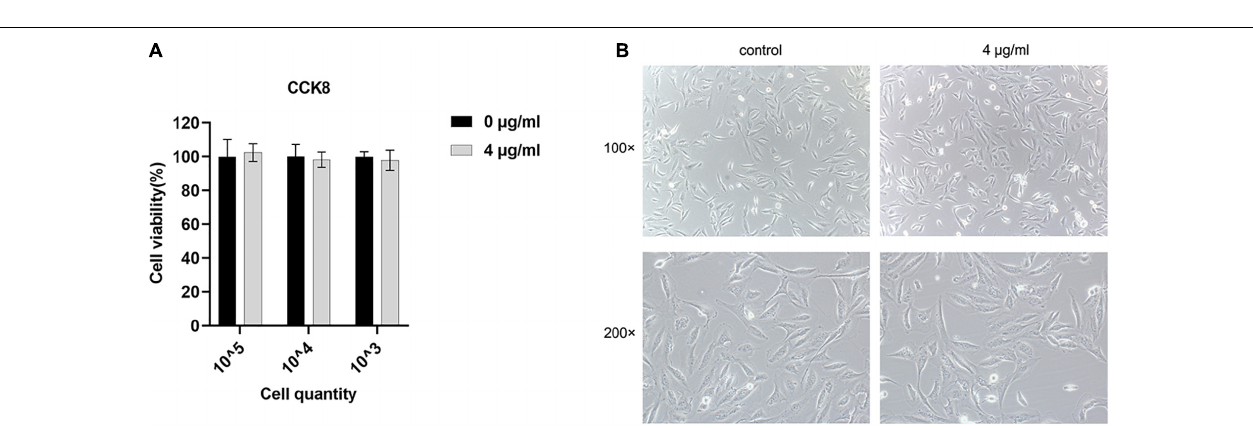
FIGURE 10 | The effect of MRSA strains with SYG-180-2-2 treatment on biofilm-related gene expression. * P < 0.05, ** P < 0.01, *** P < 0.001, and **** P < 0.0001.